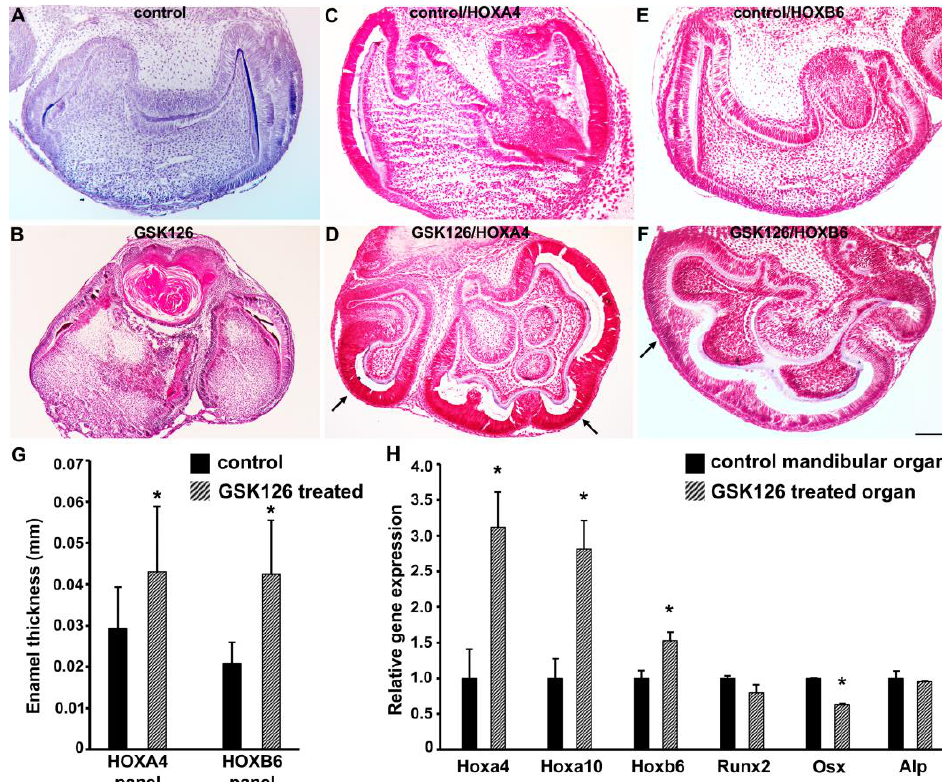
Figure 6. Small molecule-mediated HOX gene reactivation in mouse tooth organs. ( A – F ) Immuno- histochemical analysis of control and GSK126-treated mouse tooth germs. ( A ) Hematoxylin-stained control mouse tooth organ serving as a negative control for HOX antibody detection. ( B ) Repre- sentative mouse tooth organ treated with GSK126 for 10 days, stained using Masons Trichrome stain. ( C – F ) Immunohistochemical detection of HOXA4 and HOXB6 expression in control tooth organs ( C , E ) and GSK126-treated tooth organs ( D , F ). Sites of distinct immunohistochemical reactions are marked with an arrow in ( D , F ). Sections were counterstained with hematoxylin and visualized. ( G ) Comparison of enamel thickness between control and GSK126-treated tooth organs from panels ( C – F ). Fifty to one hundred measurements were performed on each sample for each experimental condition using Image J. (H ) qPCR analysis comparing expression levels of HOX genes and key mineralization-related genes between control and GSK126-treated tooth organs. Samples for gene expression comparison were obtained from more than 6 individually treated tooth germs. Differ- ences were considered as statistically significant (*) at P < 0.05. Scale, 0.1 mm.